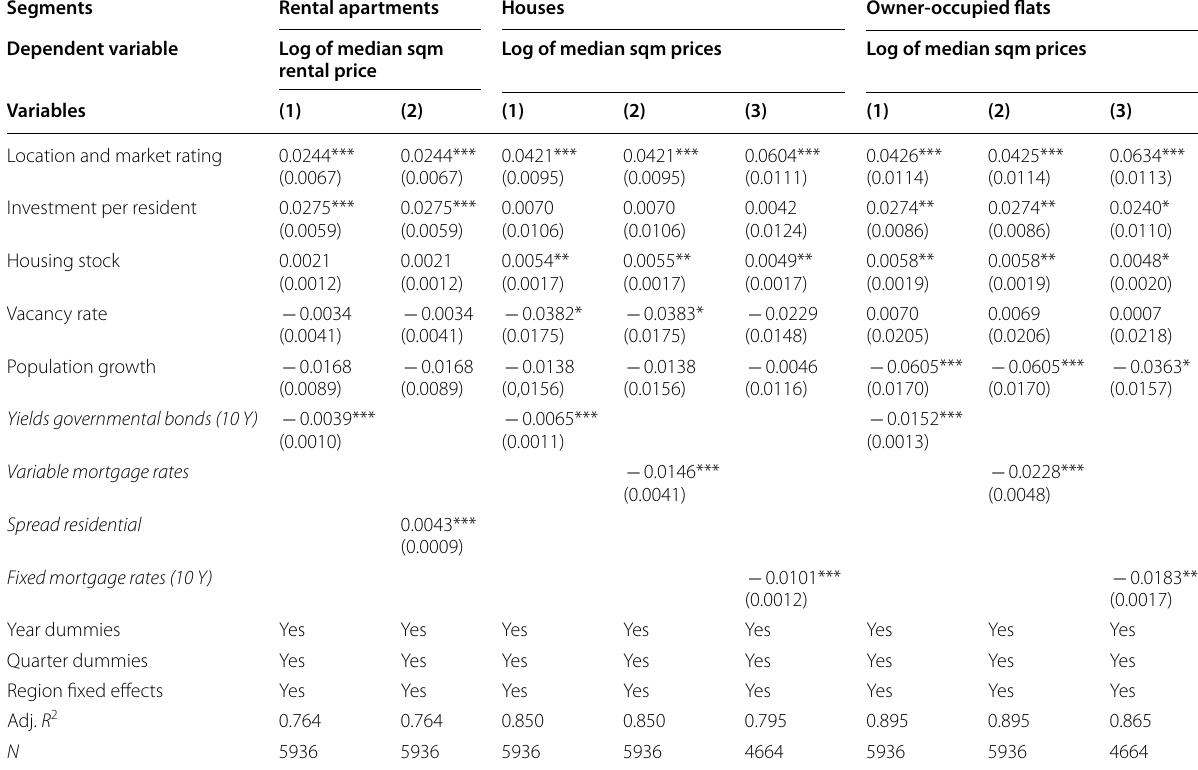
Displayed coefficients are the results of a panel fixed-effect regression model including regional fixed effects for each MS-region. Robust standard errors are displayed in brackets. In models (1) and (2), the time frame was limited to 56 quarters from 2005 Q1 to 2018 Q4. In model (3) for houses and owner-occupied flats, the time frame was limited to 44 quarters from 2008 Q1 to 2018 Q4. Signif. codes: “***” 0.001, “**” 0.01, “*” 0.05, “.”